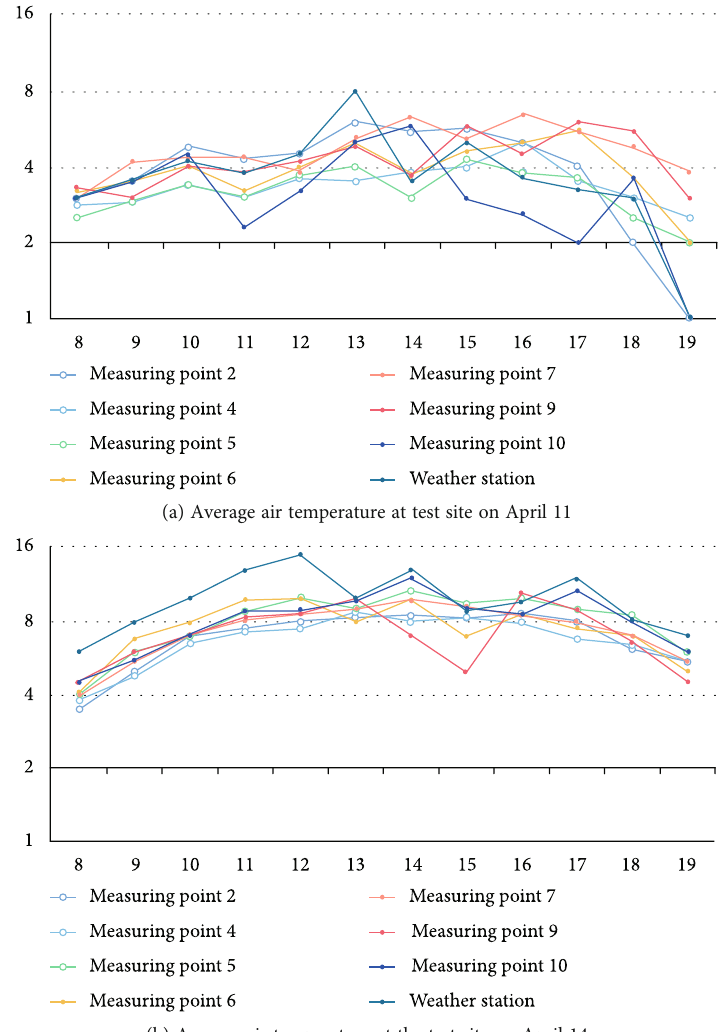
Figure 4: Average air temperature of each measuring point at the test